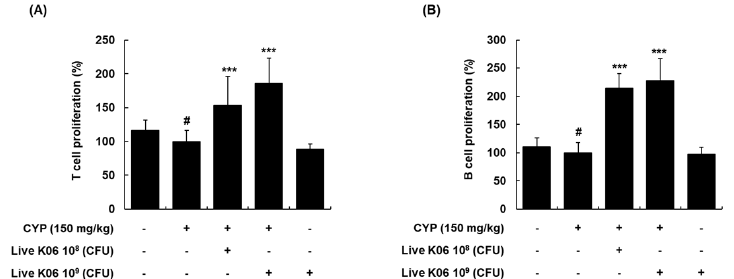
Figure 3. Effects of live K040706 on the proliferation of T and B cells in CYP-treated mice. ( A , B )